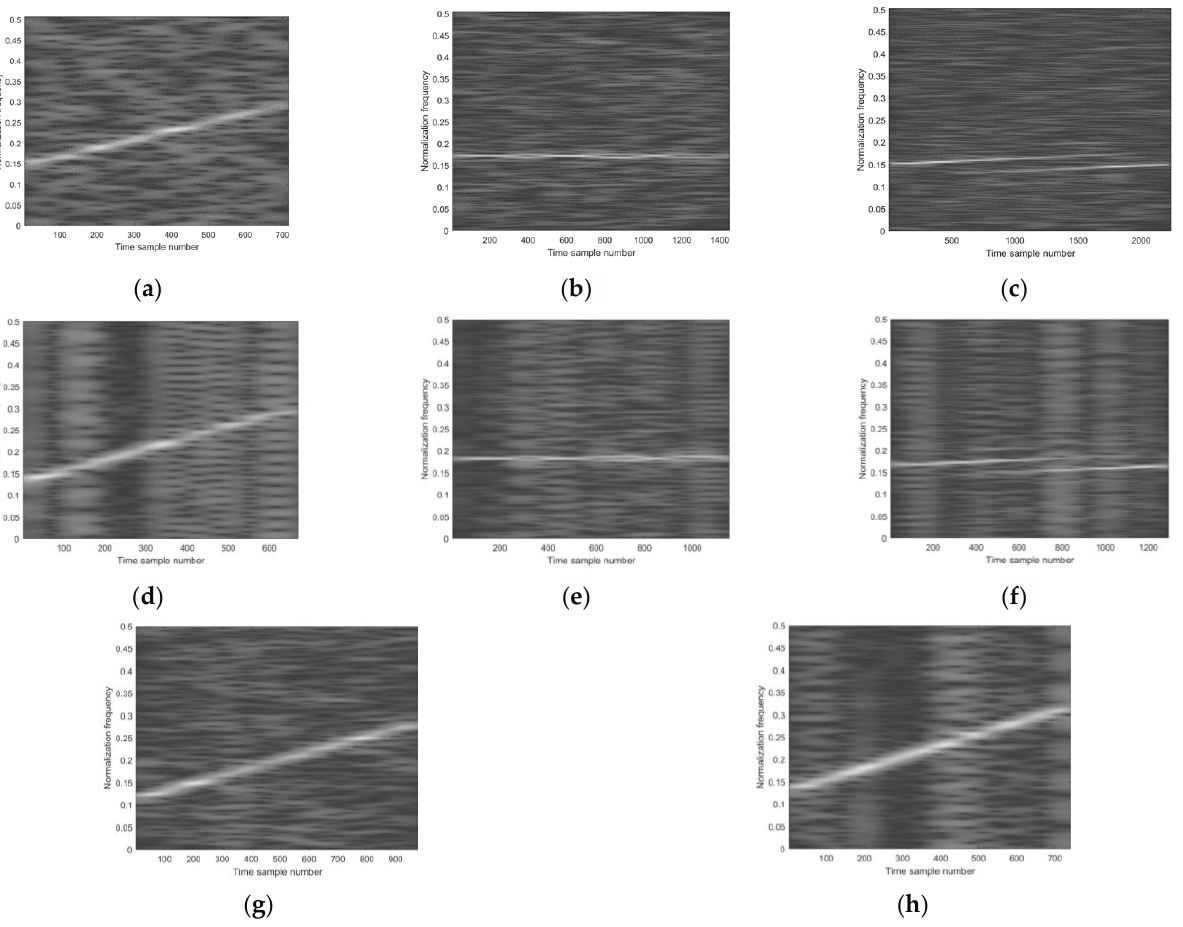
Figure 3. The time – frequency images: ( a ) LFM signal under Gaussian noise, ( b ) BPSK signal under Gaussian noise, ( c ) Frank signal under Gaussian noise, ( d ) LFM signal under impulsive noise, ( e ) BPSK signal under impulsive noise, ( f ) Frank signal under impulsive noise, ( g ) filtered image of LFM signal under Gaussian noise and ( h ) filtered image of LFM signal under impulsive noise.